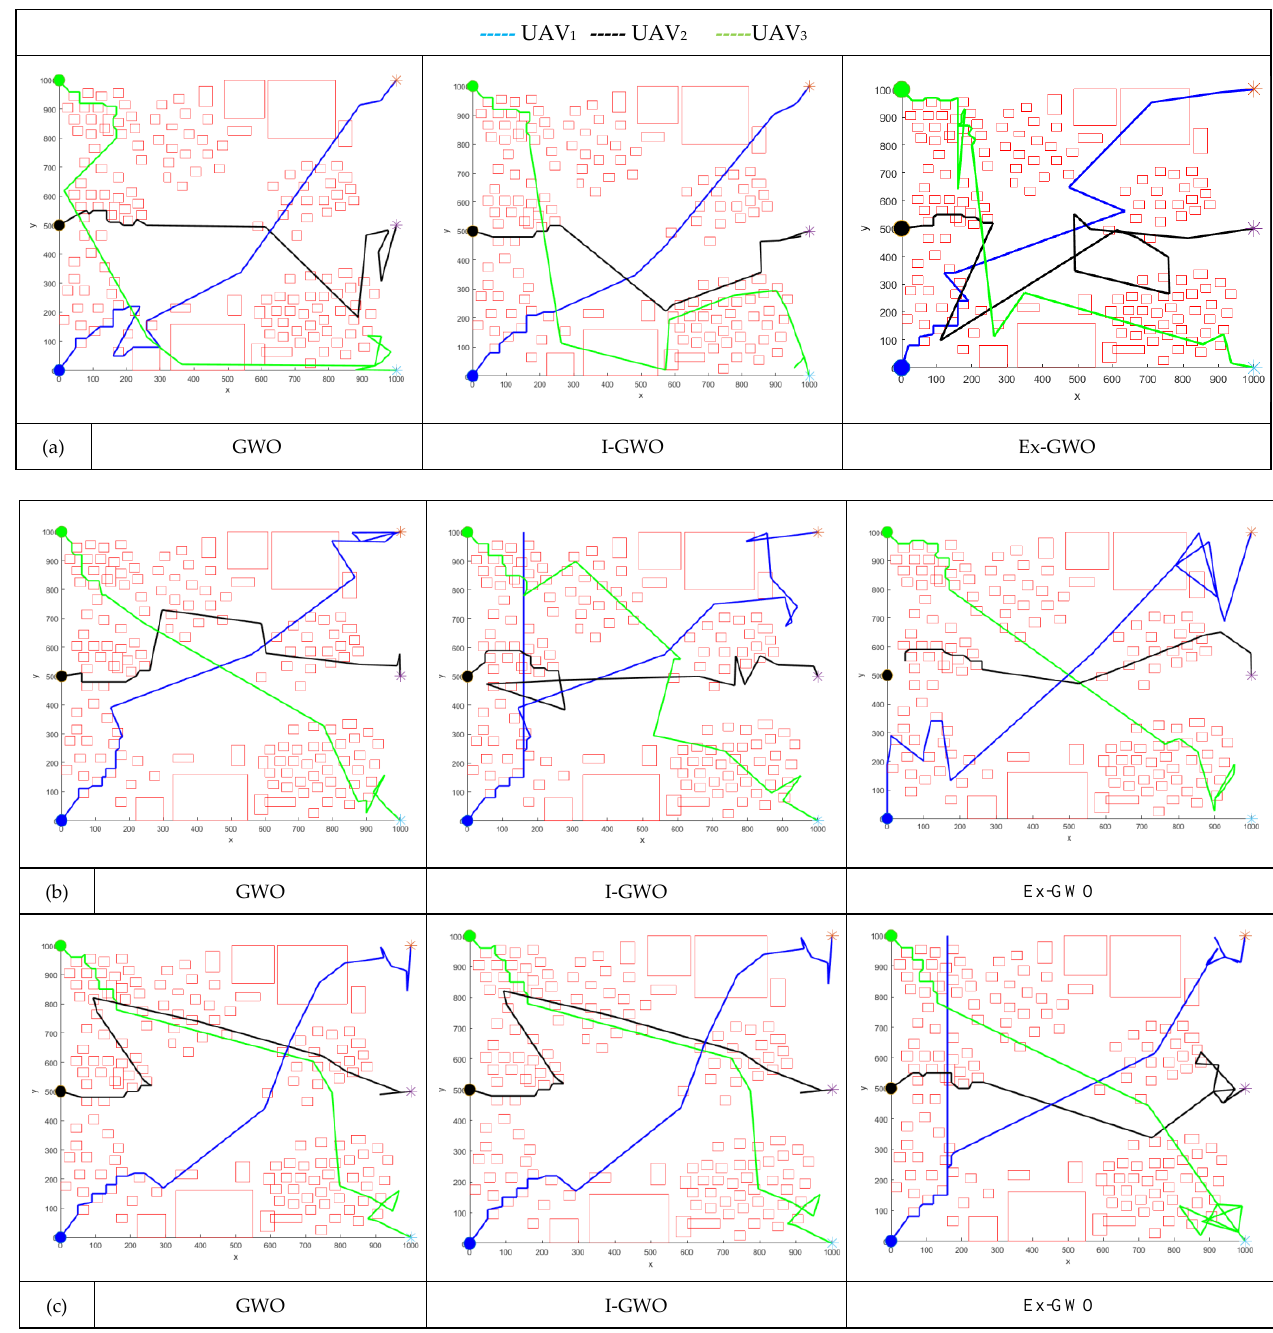
Figure 7. The movement of UAVs on the generated paths in each method. ( a ) population of 30, 50 iterations; ( b ) population of 50, 100 iterations; ( c ) population of 100, 200 iterations.